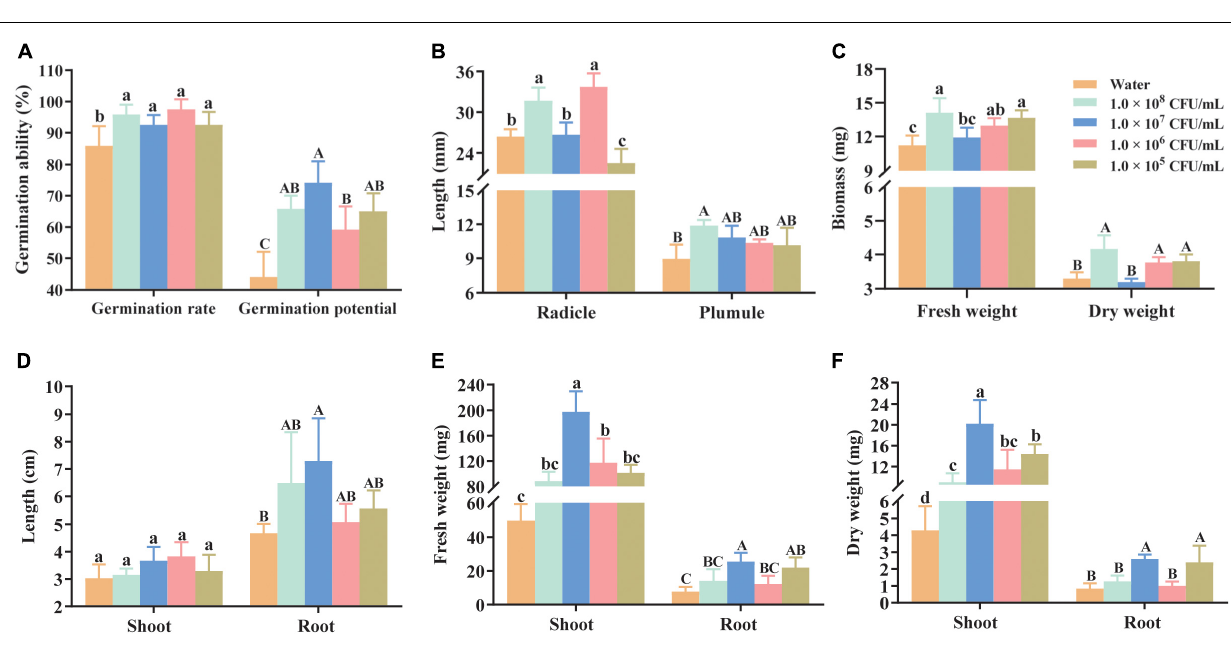
( Figure 5 ) and its drought tolerance by inducing proline